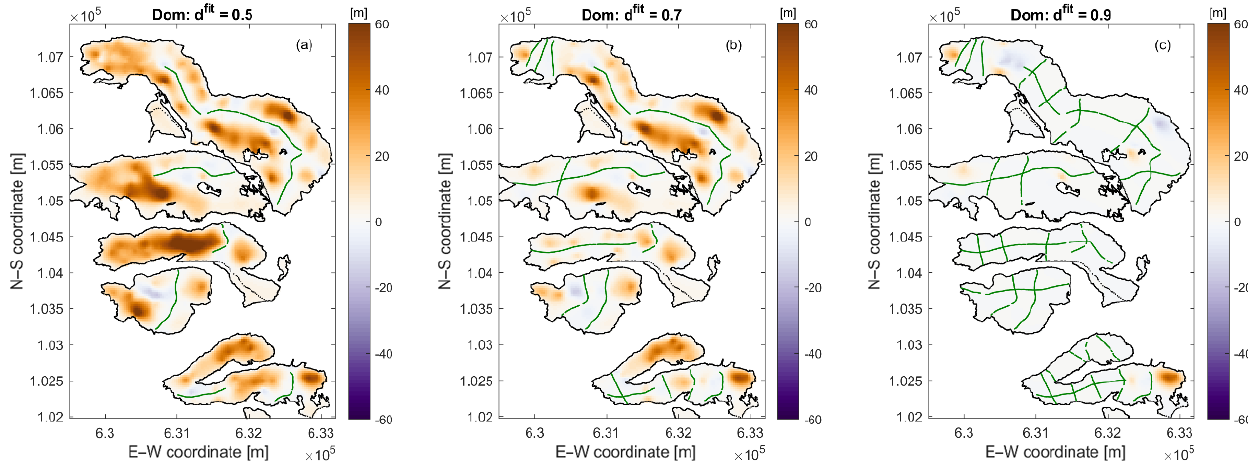
Figure 8. Dom model misfit h true − h est k after selected stages of the experimental design procedure using observed data (see also vertical dashed lines in Fig. 5). The selected GPR profiles are superimposed with green